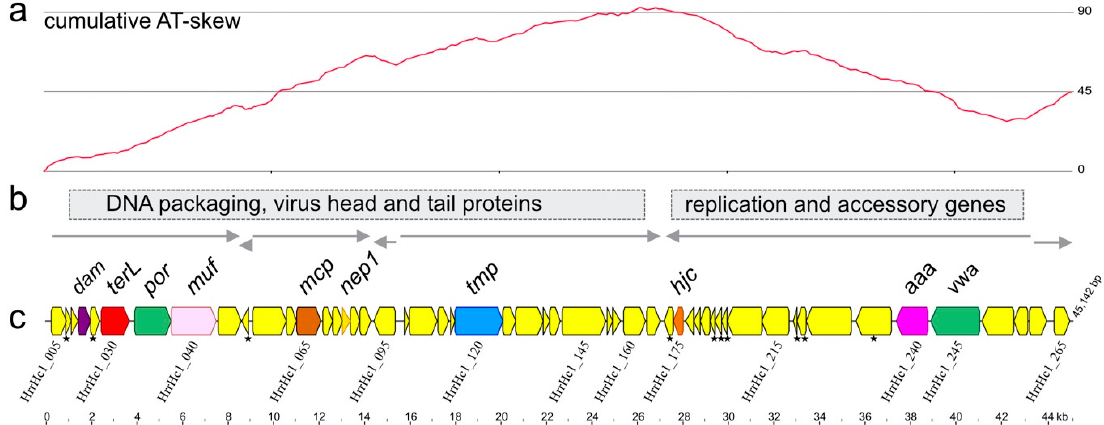
Figure 1. ( a ) Cumulative AT-skew plot (window = 45 nt) of Hardycor1 genome. ( b ) Functional modules and predicted transcription directions. ( c ) Genome map of Hardycor1. Gene names and the proteins they specify: dam , Dam methylase; terL , large subunit terminase; por , portal protein; muf , MuF-family head morphogenesis protein (SSP1 gp7 family); mcp , major capsid protein; nep1 , neck protein of type 1; tmp , tape measure protein; hjc , Holliday junction resolvase Hjc; aaa , AAA ATPase; vwa , Von Willebrand factor type A (vWA) interaction domain that includes a metal ion-dependent adhesion site (MIDAS). Asterisks immediately below gene arrows indicate the predicted hypothetical proteins contain CxxC motifs. The locus tags (e.g., HrrHc1_005) of several genes are shown below the gene map. Scale at bottom represents DNA length in kb.